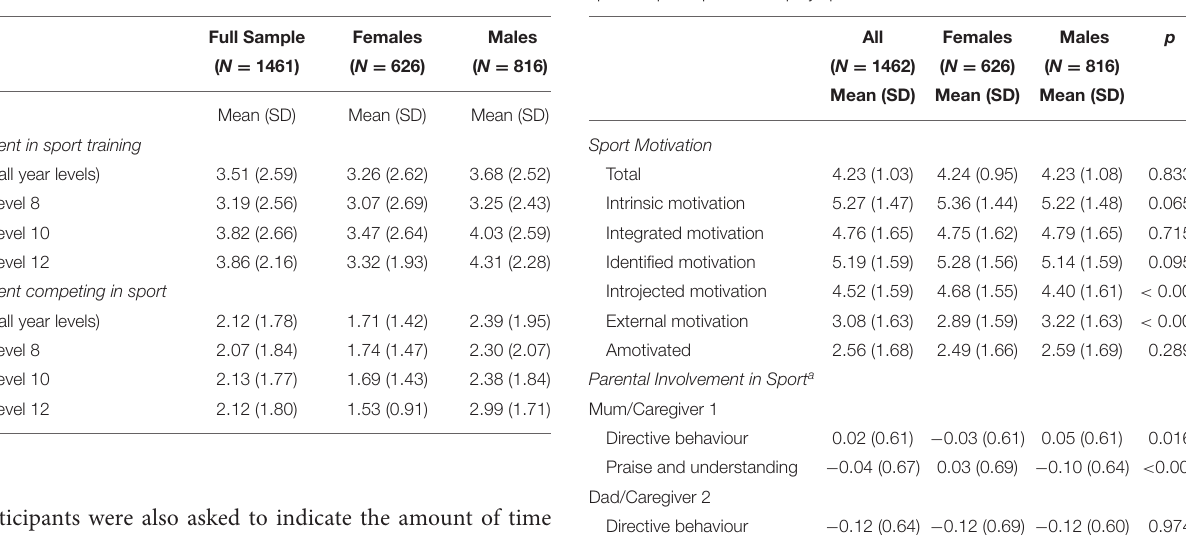
TABLE 4 | Summary of the amount of time spent playing and competing in a sport.